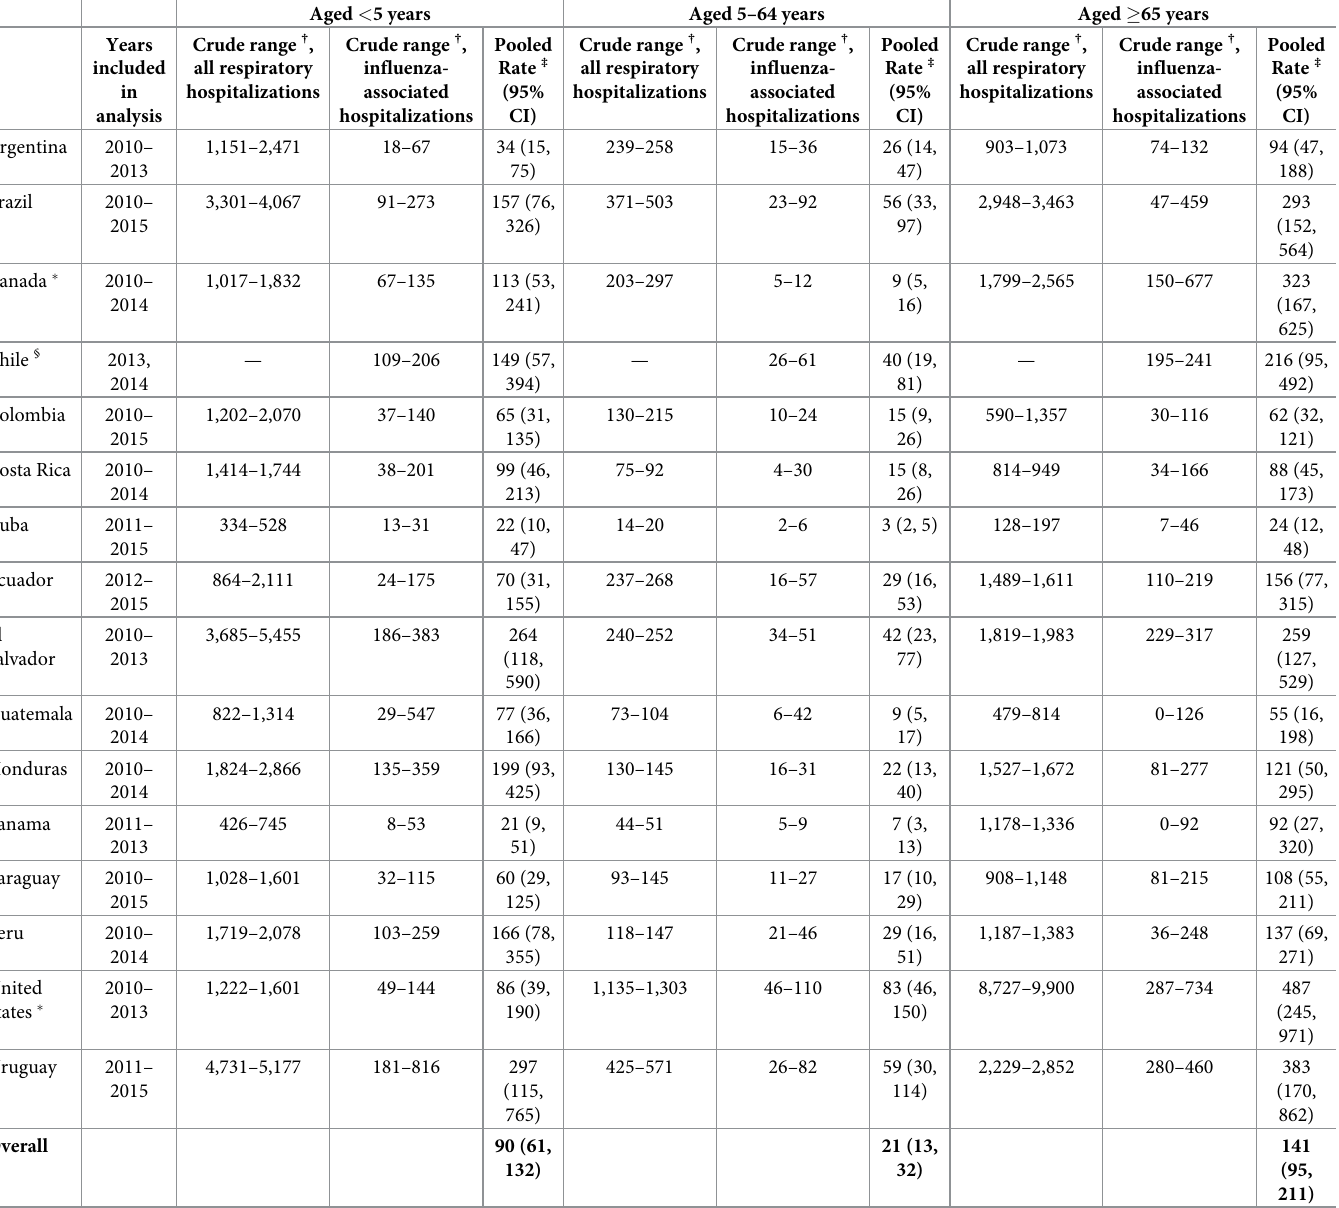
Table 1. Crude annual ranges and average pooled estimates of influenza-associated hospitalization rates, per 100,000 people, by age group for 16 countries provid- ing